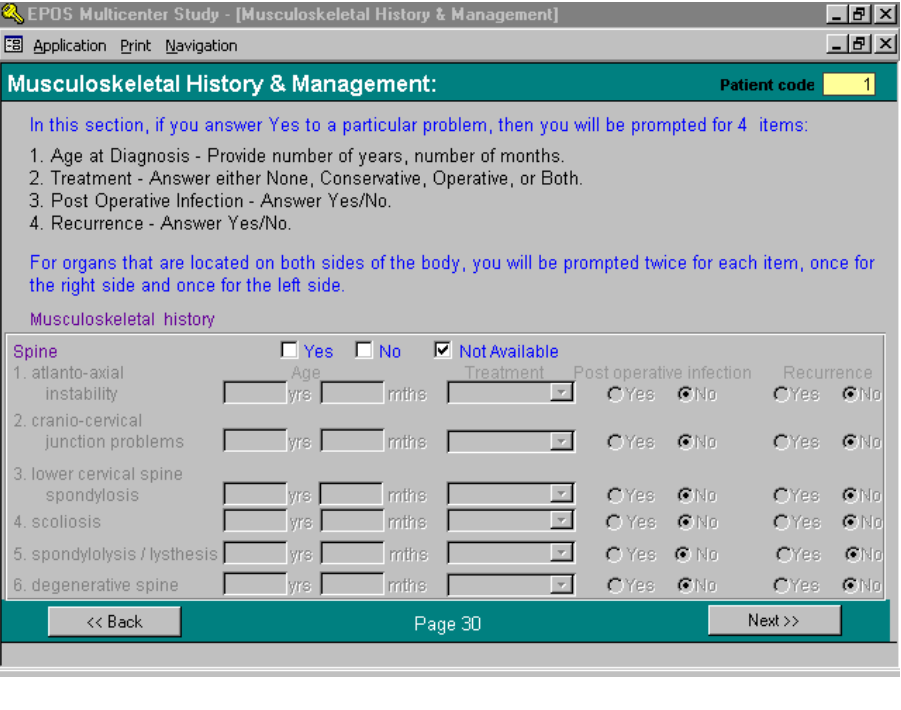
FIGURE 3 . The initial data entry screen for musculoskeletal history and management.